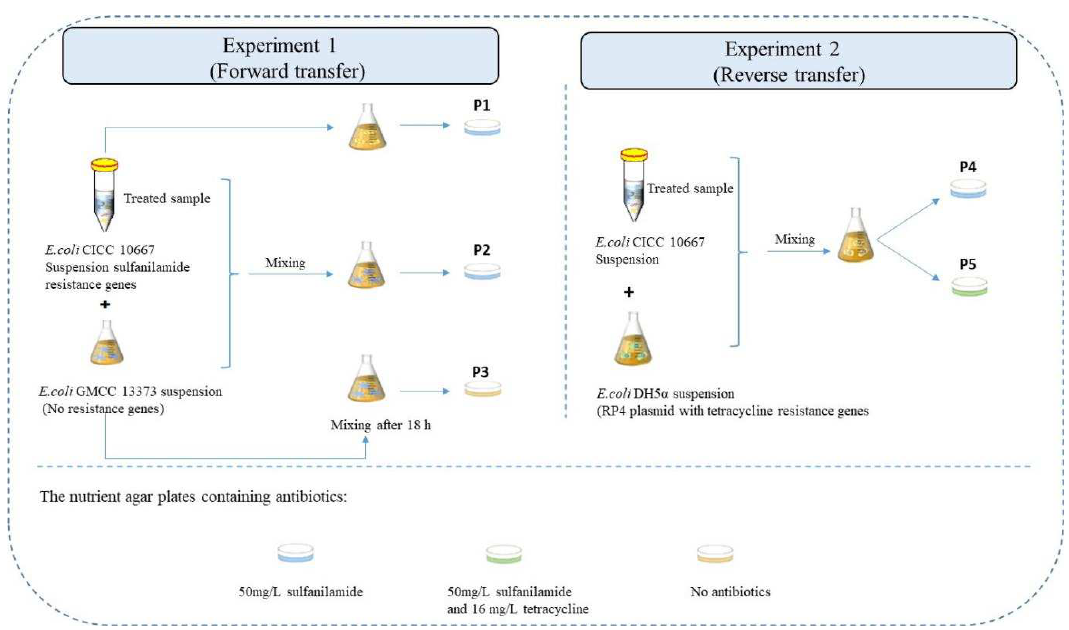
Figure 2. Process of the HGT experimental design. Experiment 1 (forward transfer): treated sample and E. coli GMCC 13373 as donor and recipient strains, respectively; Experiment 2 (reverse transfer): treated sample and E. coli DH5α as recipient and donor strains, respectively.